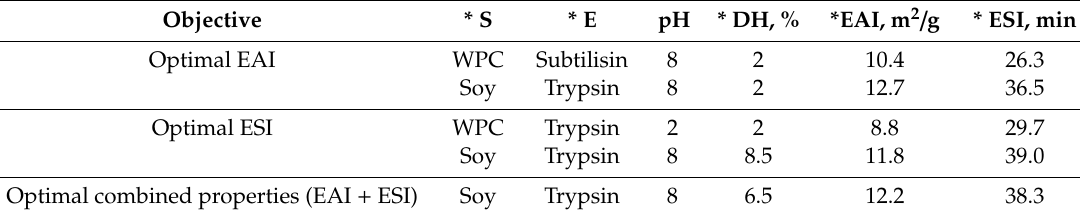
Table 1. The optimal substrate, enzyme and hydrolysis parameters (pH, DH) for the maximal EAI, ESI or combined